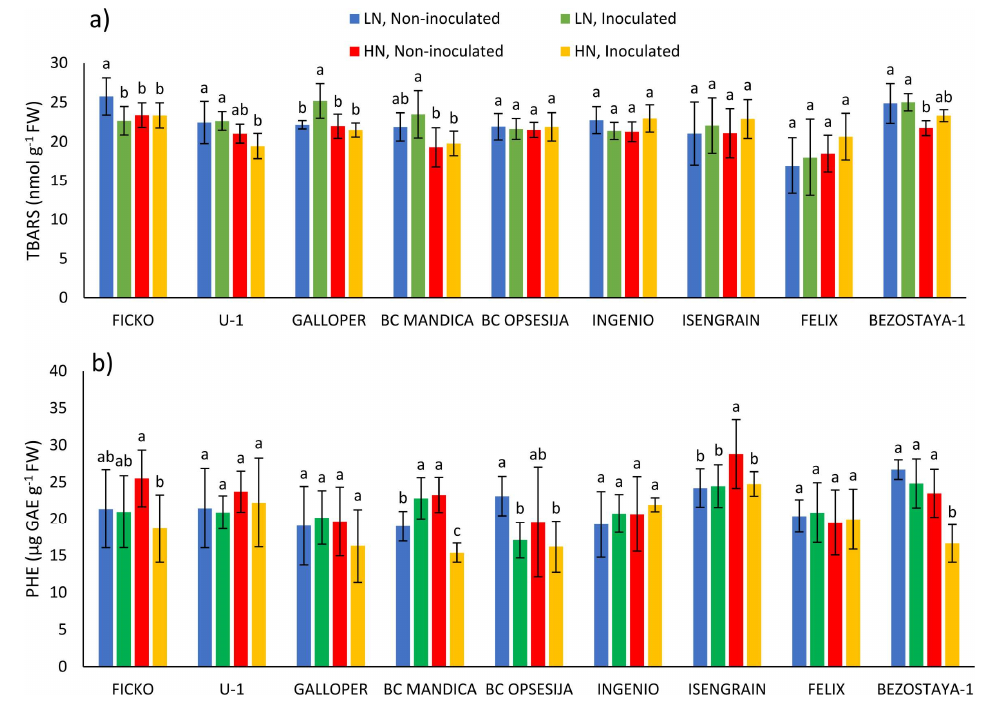
Figure 1. TBARS content ( a ) and soluble phenolic (PHE) content ( b ) in spikes of nine wheat varieties under different nitrogen (LN—low nitrogen; HN—high nitrogen) and Fusarium (non-inoculated and inoculated) treatments. Values are means of six replicates ± standard deviation (SD). Different letters above the bars indicate significant differences according to Fisher’s LSD test ( p ≤ 0.05) among different treatments in each variety